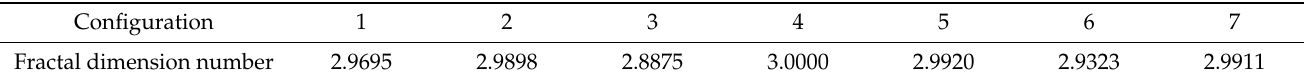
Table 1. Fractal dimension number of the seven configurations shown in Figure